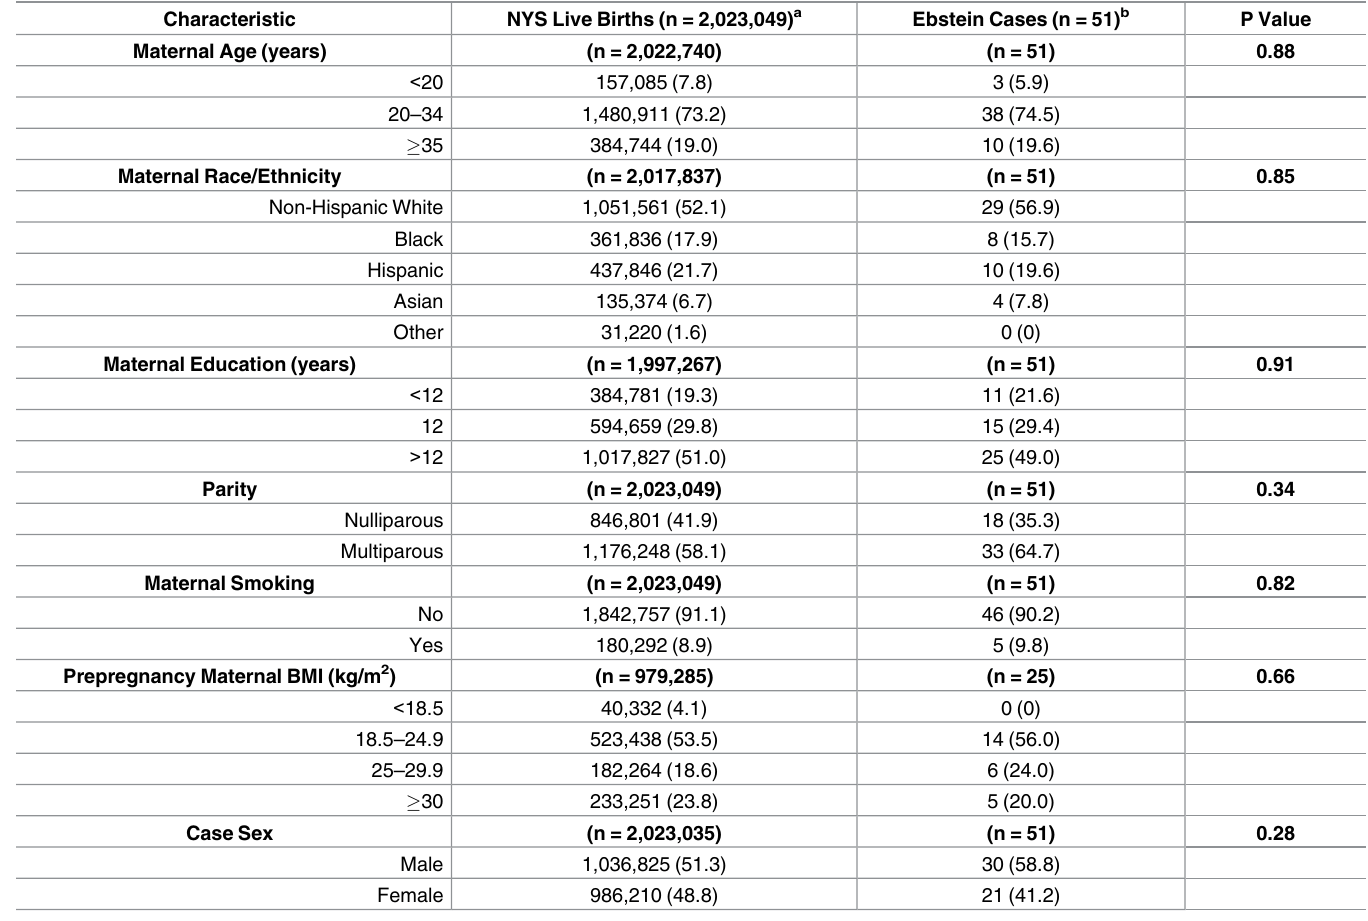
Table 1. Characteristics of isolated EA cases compared to NYS live births.